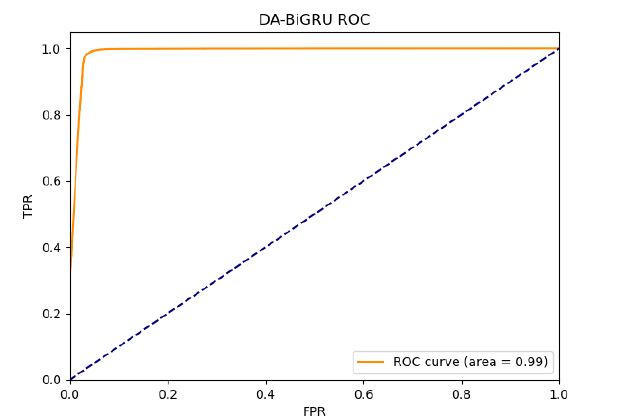
Figure 12. ROC curve of the experimental